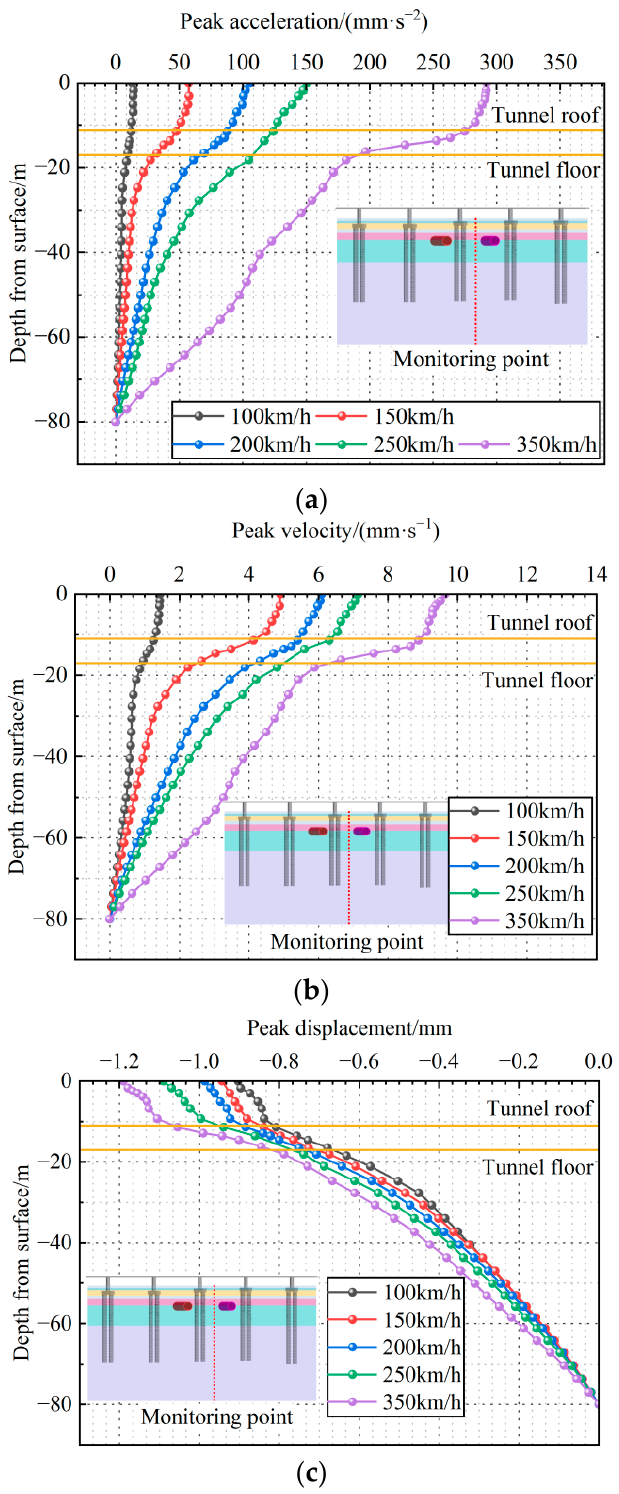
Figure 12. Vertical dynamic response characteristics of the foundation for different train